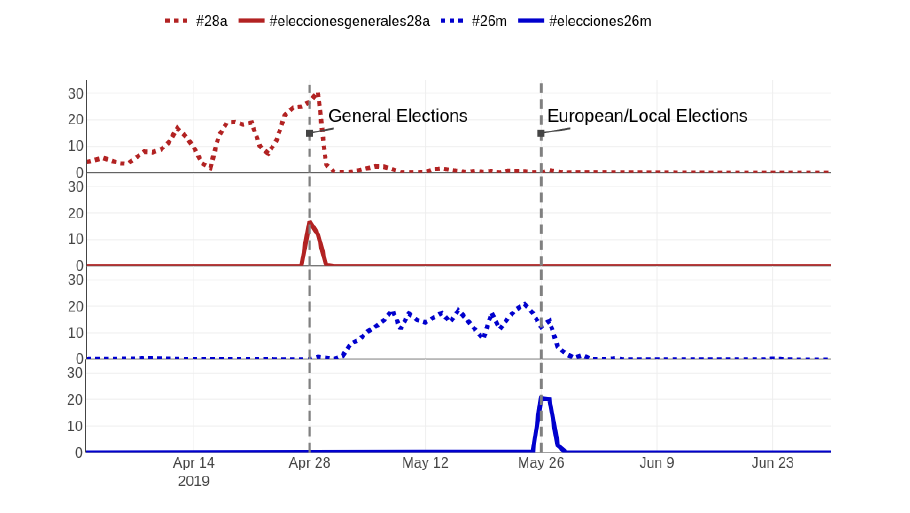
Figure 4. Daily relative amount of tweets extracted using #28a, #26m, #eleccionesgenerales28a, and #elecciones26m (in percentage). Notice the spikes at the end of each electoral period for the latter